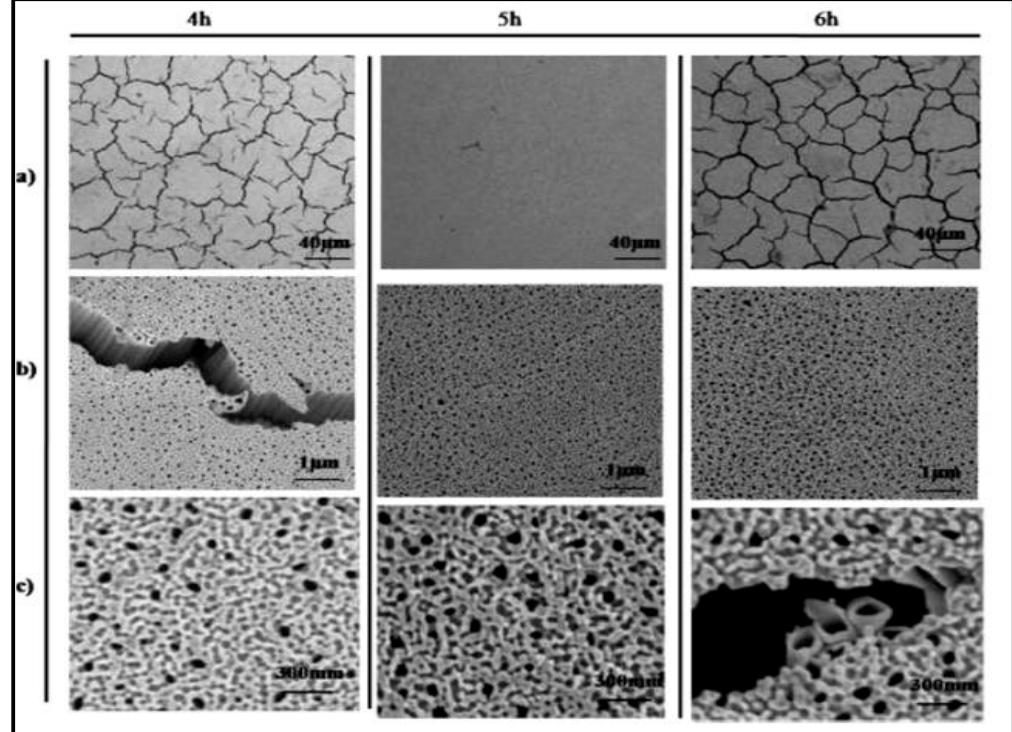
Figure 1. Scanning electron microscopy (SEM) images of Ti-30Ta alloy surface after anodization process in NH 4 F 0.25% + glycerol at 30 V for 4, 5, and 6 h. The annealing process was performed at 530 °C (5 °C/min) for 1 h. ( a ) Micrographs of superficial morphology. ( b ) Micrographs of superficial morphology in higher magnification. Nanotubes cover the substract surface. ( c ) Tilted micrographs of superficial morphology. They show the morphology height.